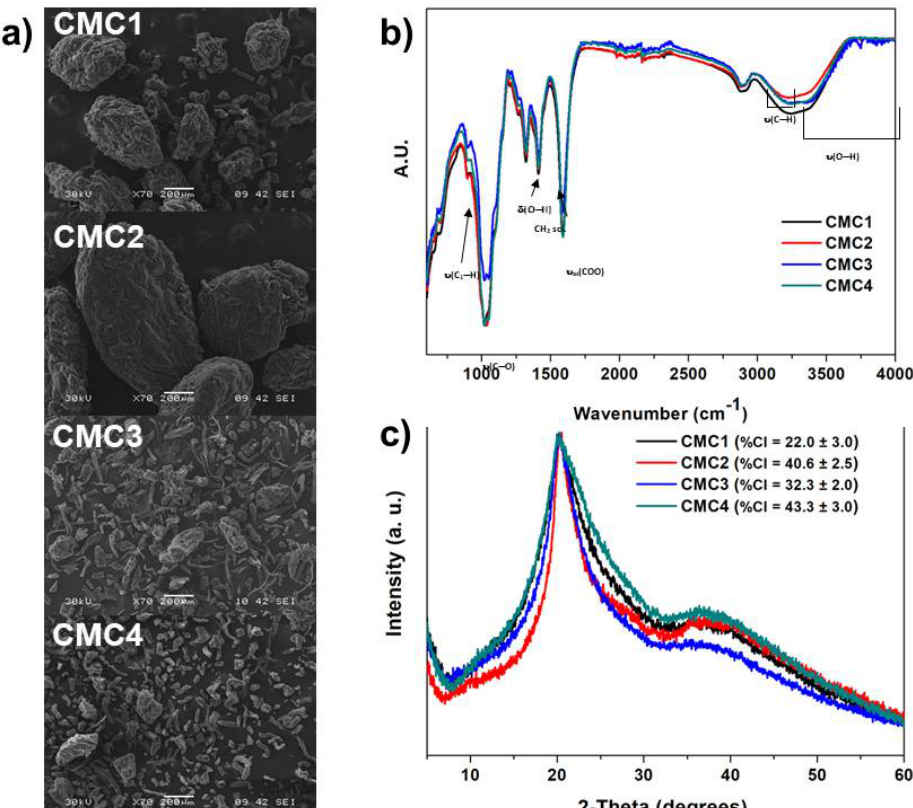
Figure 2. Structural characterization of CMC samples by ( a ) scanning electron microscopy, ( b ) Fourier-Transform Infrared Spectrometry, and ( c ) powder X-ray diffraction analysis.